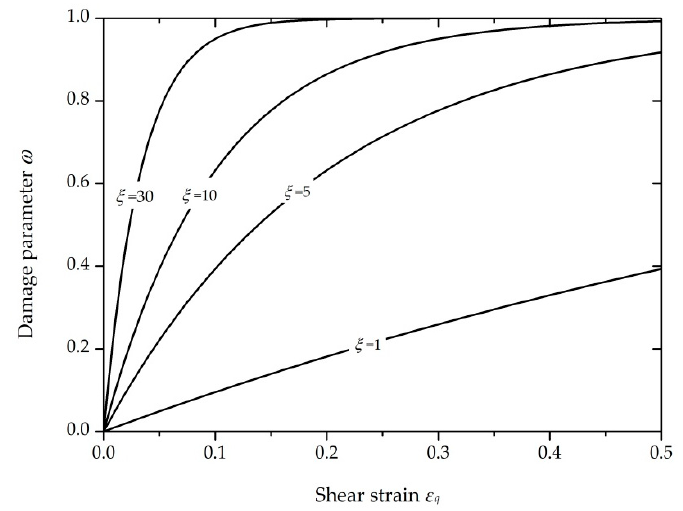
Figure 3. Relationships between the damage parameter ω and shear strain.